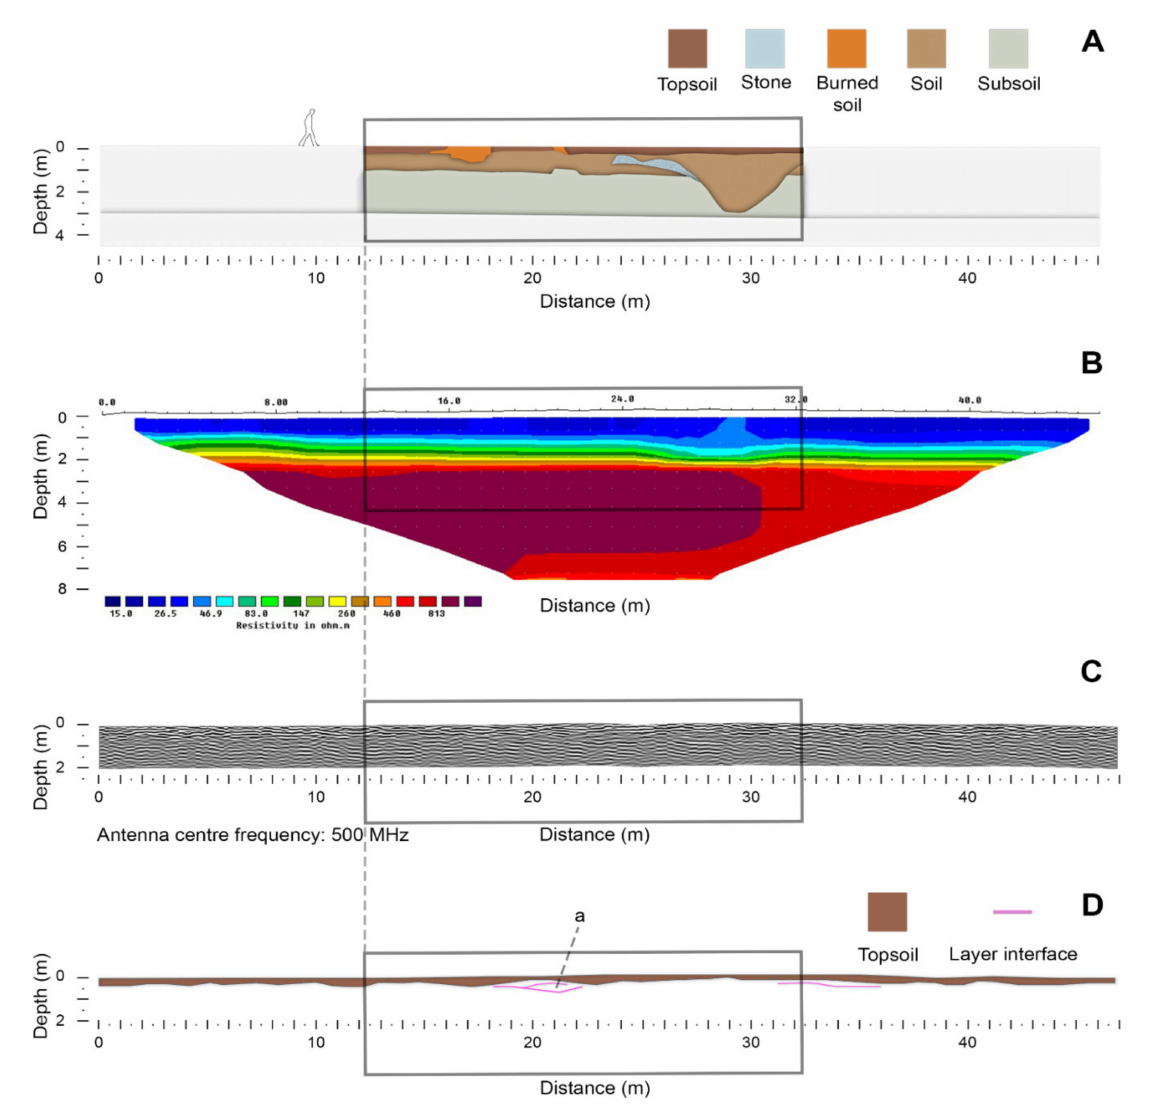
Figure 12. Pobedim. ( A ): Profile of the hillfort’s fortification based on the results of archaeological excavation ([47], Figure 5). ( B ): Electrical resistivity tomography model in Wenner configuration of the surveyed fortification. ( C ): GPR vertical time/depth radarogram from antenna with 500 MHz centre frequency. ( D ): Interpretation of the GPR